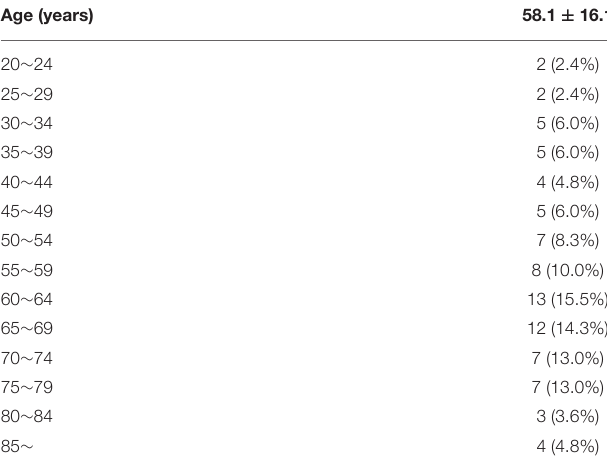
TABLE 3 | Age distribution of